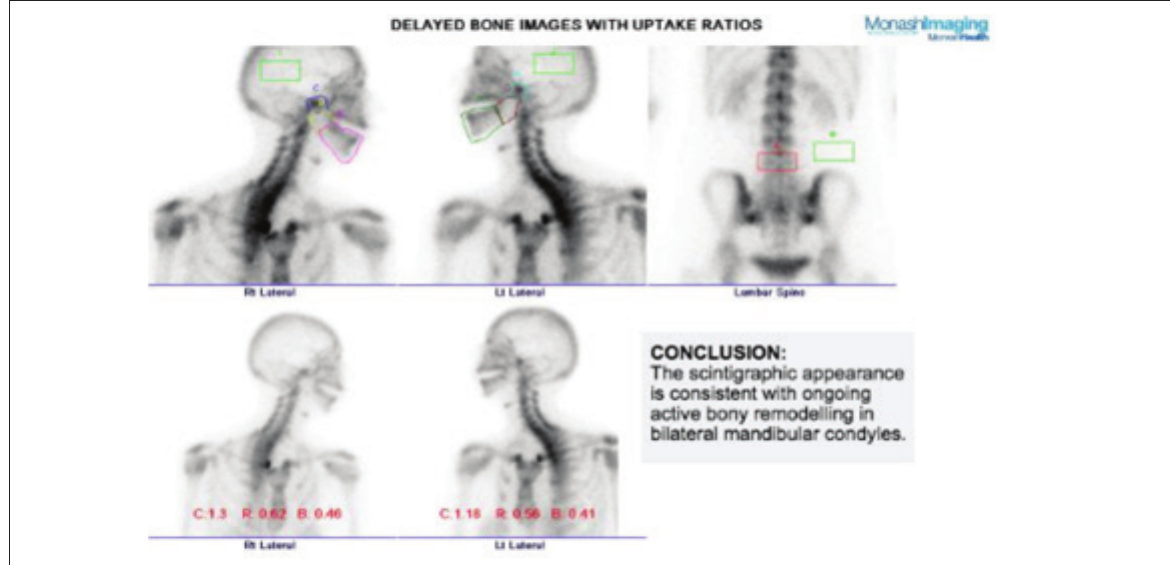
Figure 7. Nuclear medicine bone scan showing active bony remodelling; July 2016. Figure 8: Nuclear medicine bone scan showing cessation of bony remodelling; July 2017